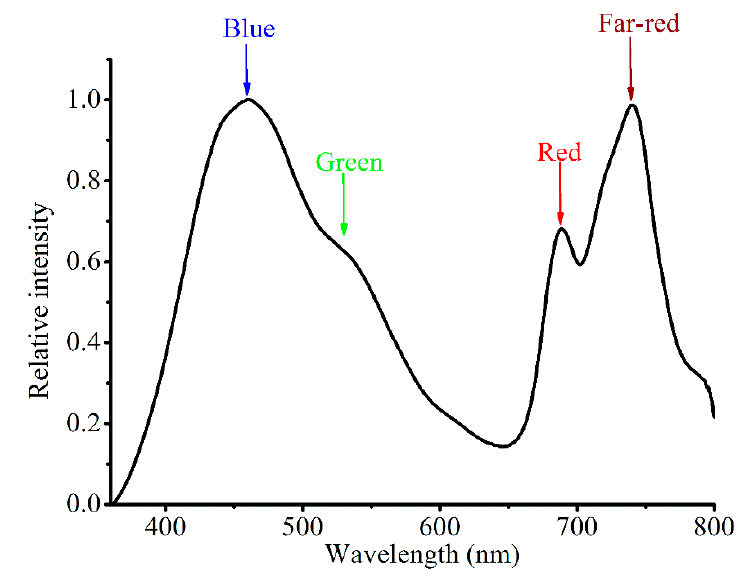
Figure 3. Paddy rice foliar fluorescence spectrum excited by 355 nm excitation light.